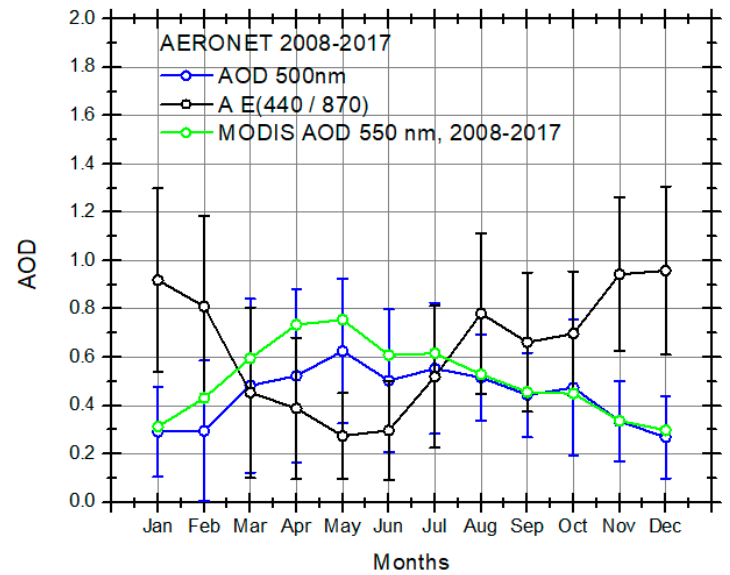
Figure 3. Number of SDS events (blue bars), along with their lasting time period (in days) (red line), as observed by AERONET over Kuwait, during the time period 2008–2017.